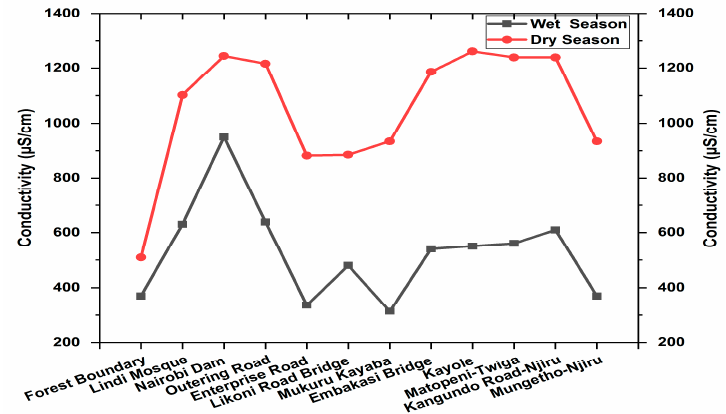
Figure 6. Conductivity levels of Ngong River measured between April and August 2021.